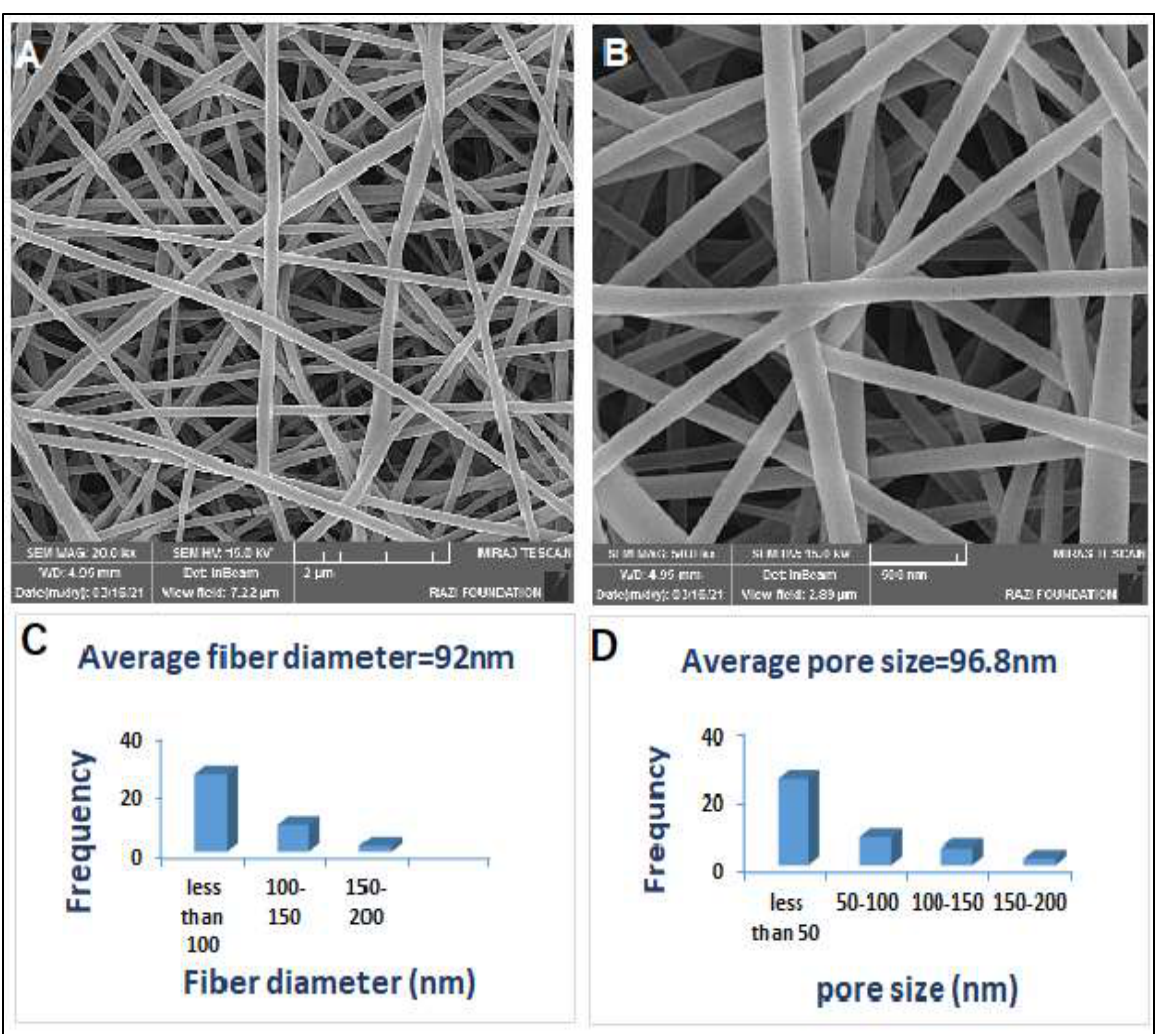
Figure 10: FE-SEM results of the synthesized PVA (12wt.%) nanofiber A) at low magnifications, and B) at high magnifications C) Average fiber diameter D) Average pore